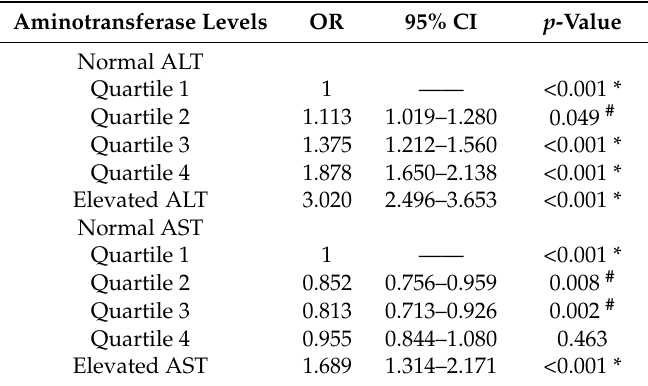
Table 4. Multiple logistic regression for metabolic